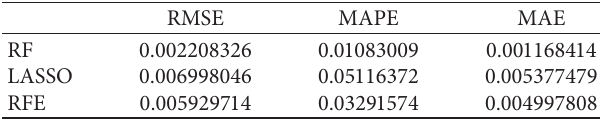
Table 1: Comparisons of regression accuracy using various algorithms.